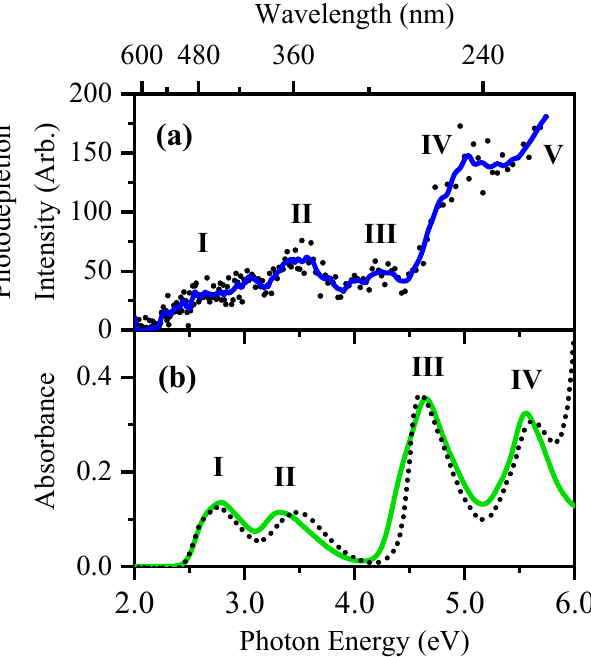
Figure 2. ( a ) Gas-phase photodepletion (absorption) spectrum of ([RF − H] − ) and ( b ) static solution- phase absorption spectrum of RF in aqueous solution (pH~5.5; solid green line) and RF in aqueous solution with trace amounts of NH 3 (pH~11.2; dotted black line).